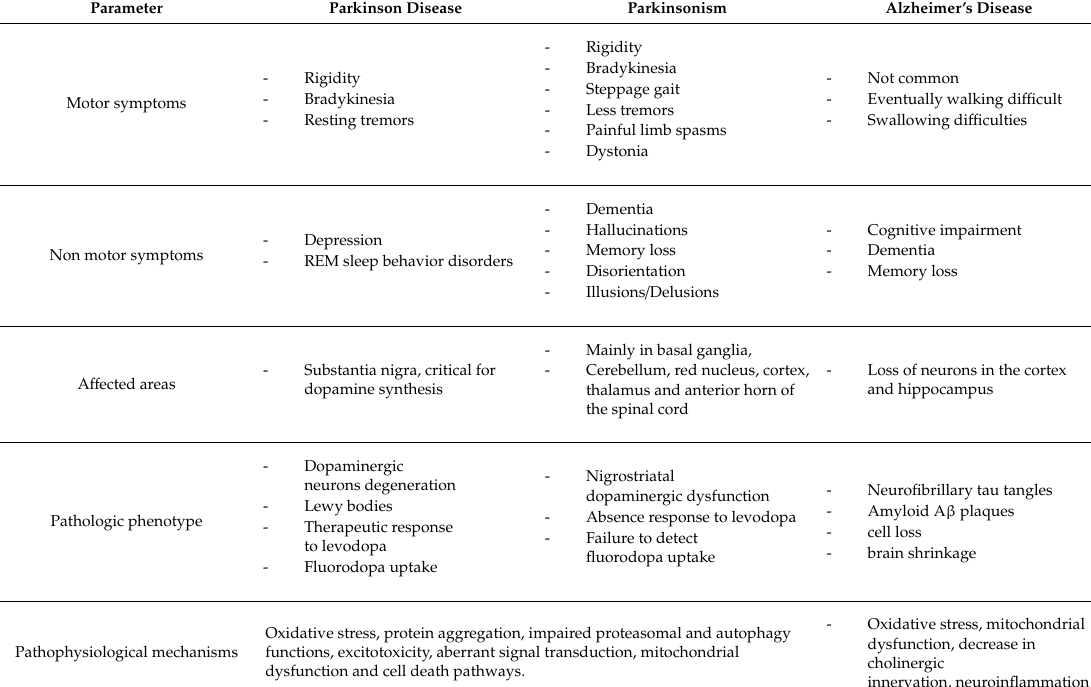
Table 1. An overview of the di ff erent findings in PD, parkinsonism, and